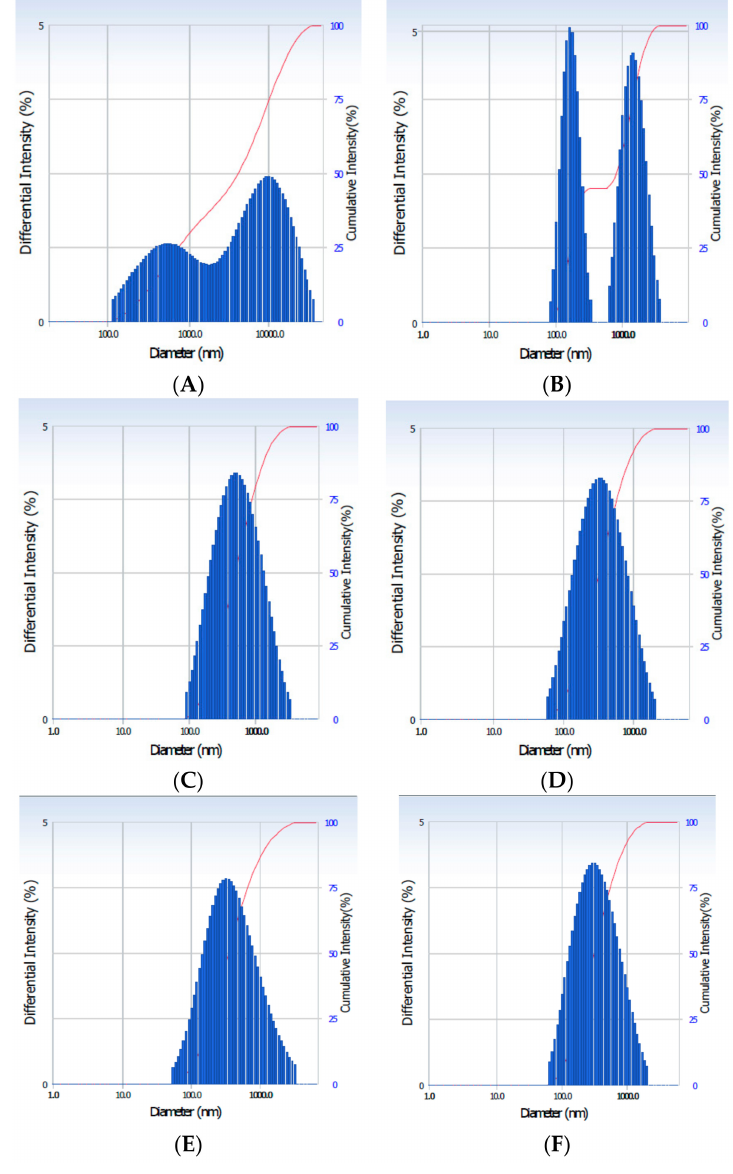
Figure 3. Particle size distribution of the AGNC formulation. ( A ): FAGN; ( B ): EAGN; ( C ): AA-EAGN; ( D ): HP-AA-EAGN; ( E ): CN-AA-EAGN; ( F ): AN-AA-EAGN. HP / CN / AN-AA-EAGN: HPMC (5% w / w ) mediated AA-EAGN. Table 4. Water solubility of the AGNC